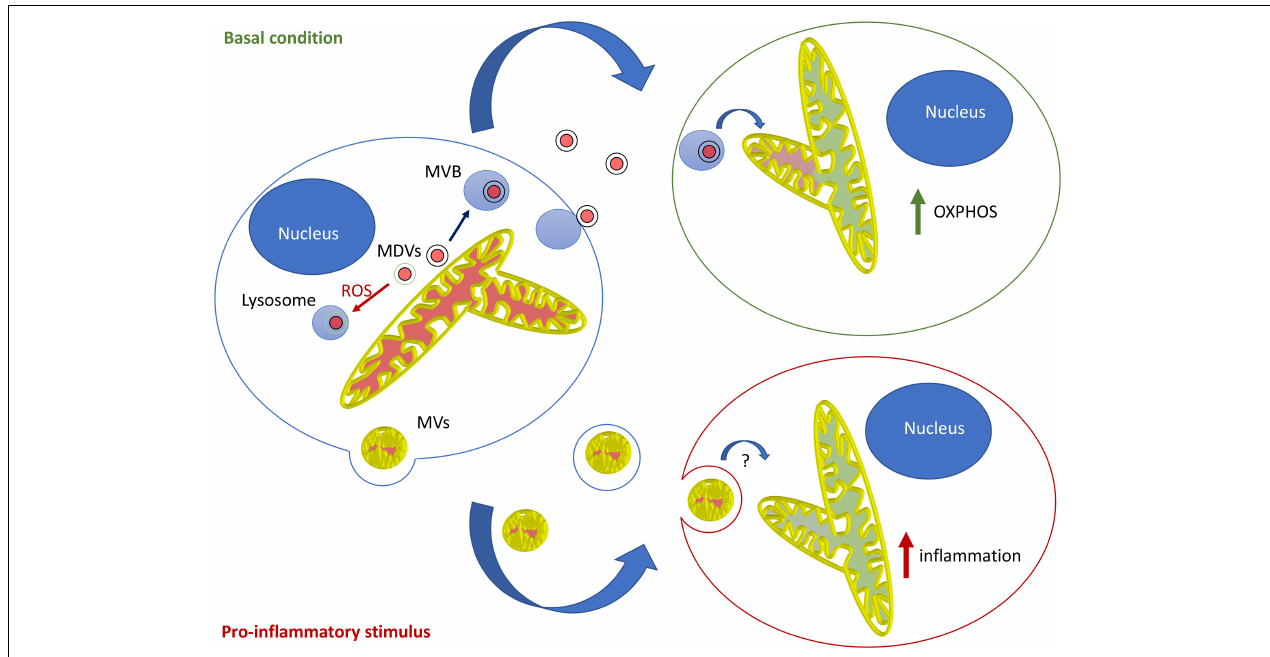
FIGURE 1 | Model for the roles and mechanisms of secretion of mitochondrial EVs. Under basal conditions, MDVs are required to package mitochondrial components into mitochondrial EVs, which serve to increase OXPHOS in recipient cells. In this setting, oxidized mitochondrial components are not released into EVs but rather sent to lysosomes for degradation through a different type of MDV (Parkin-dependent). On the other hand, pro-inflammatory stimuli like LPS cause the release of free mitochondria or mitochondria packaged within microvesicles that further stimulate